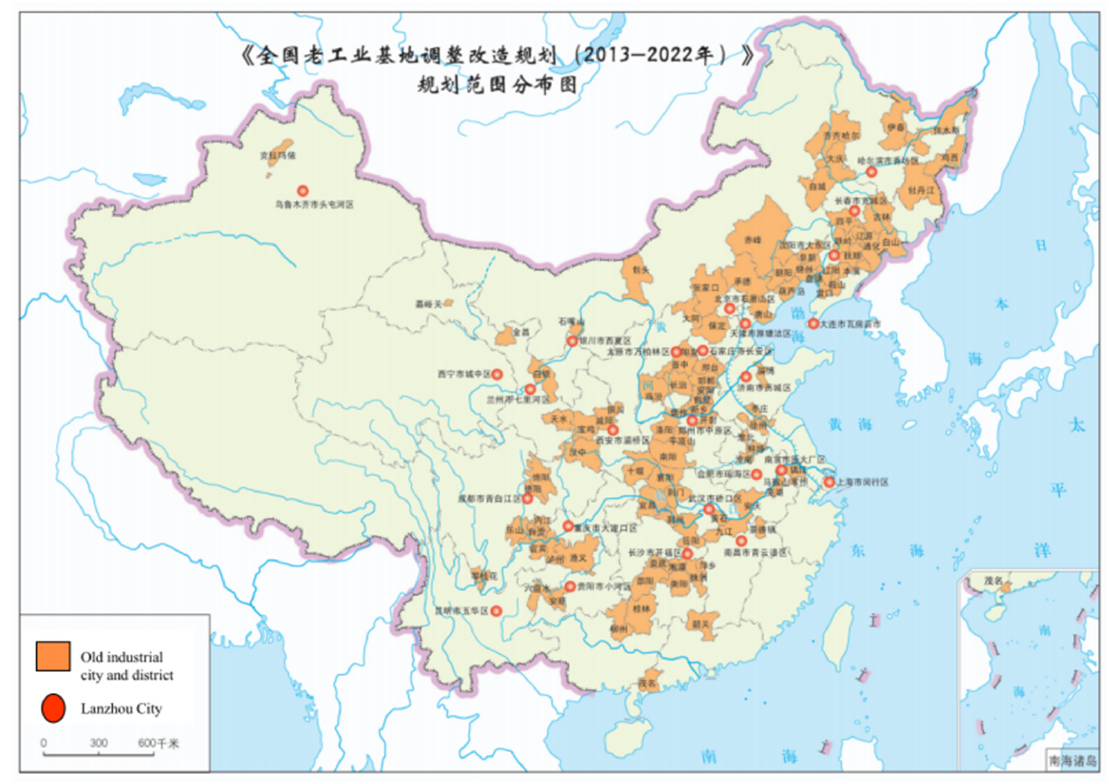
Figure 1. Key reconstruction cities in RPNOIB. Source: RPNOIB.